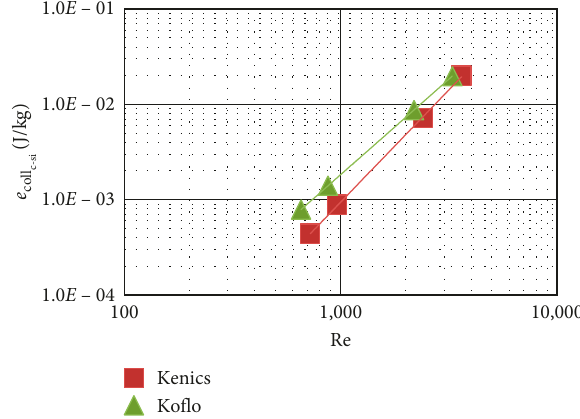
Figure 21: The unit energy caused by mechanical collisions be- tween crystals and static inserts.